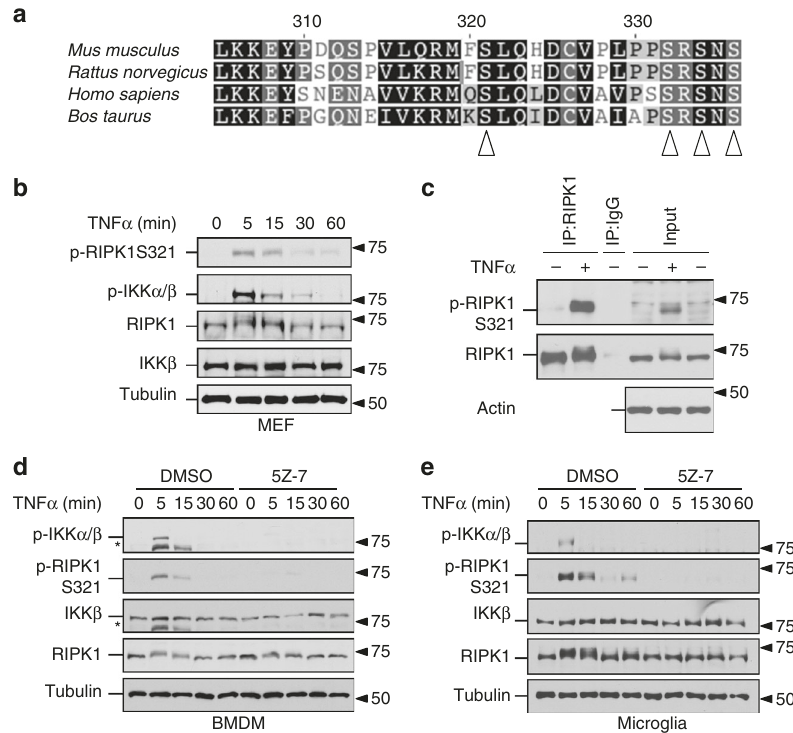
Fig. 1 TNF α induces RIPK1 phosphorylation at S321. a Alignment of amino acid sequences in the relevant part of RIPK1 intermediate domain from indicated mammalian species. S321, S332, S334 and S336 as marked by arrowheads are highly evolutionarily conserved. b S321 of RIPK1 is transiently phosphorylated after TNF α treatment. MEF cells were treated with TNF α (10 ng/ml) and the samples were collected at indicted time-points. The cell lysates were analyzed by western blot. c Anti-p-S321-RIPK1 antibody speci fi cally recognizes RIPK1 S321 phosphorylation. L929 cells were treated with TNF α (20 ng/ml) for 5 min. The cell lysates were subjected to immunoprecipitation by either RIPK1 antibody or IgG. Both lysates and IP samples were examined by western blot using anti-p-S321-RIPK1 and RIPK1 total antibodies. d , e TNF α induces RIPK1 S321 phosphorylation in murine primary BMDM and microglia cells. BMDM d and primary microglia e were pre-incubated with DMSO or TAK1 inhibitor, 5Z-7 (0.5 µ M) for 30 min and treated with TNF α (10 ng/ml). Samples were collected at indicated time-points. *, nonspeci fi c